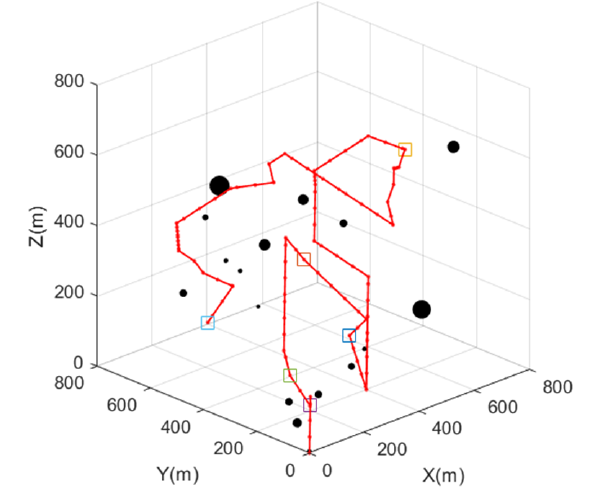
Figure 17. Target search in an obstacle environment.